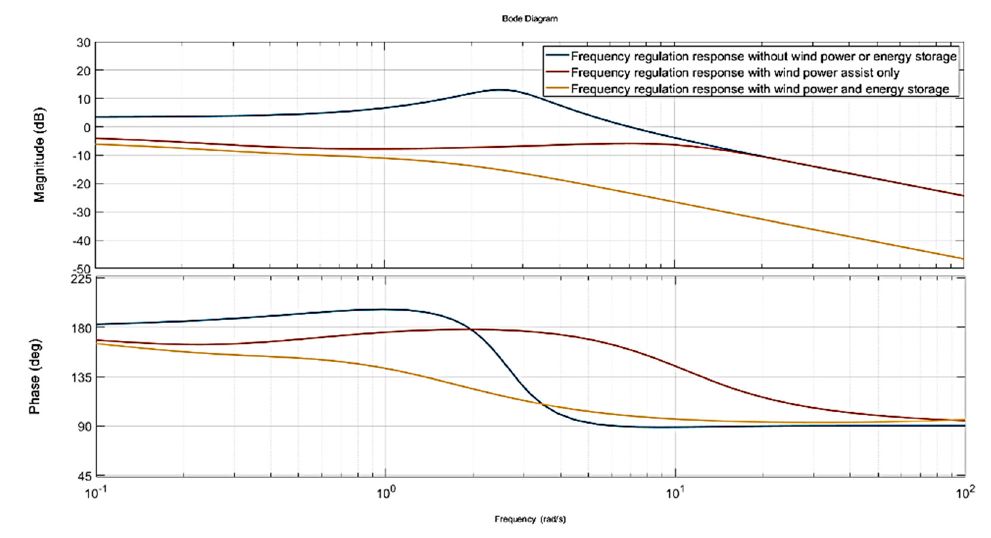
Figure 13. Bode diagram comparisons of frequency regulation methods.